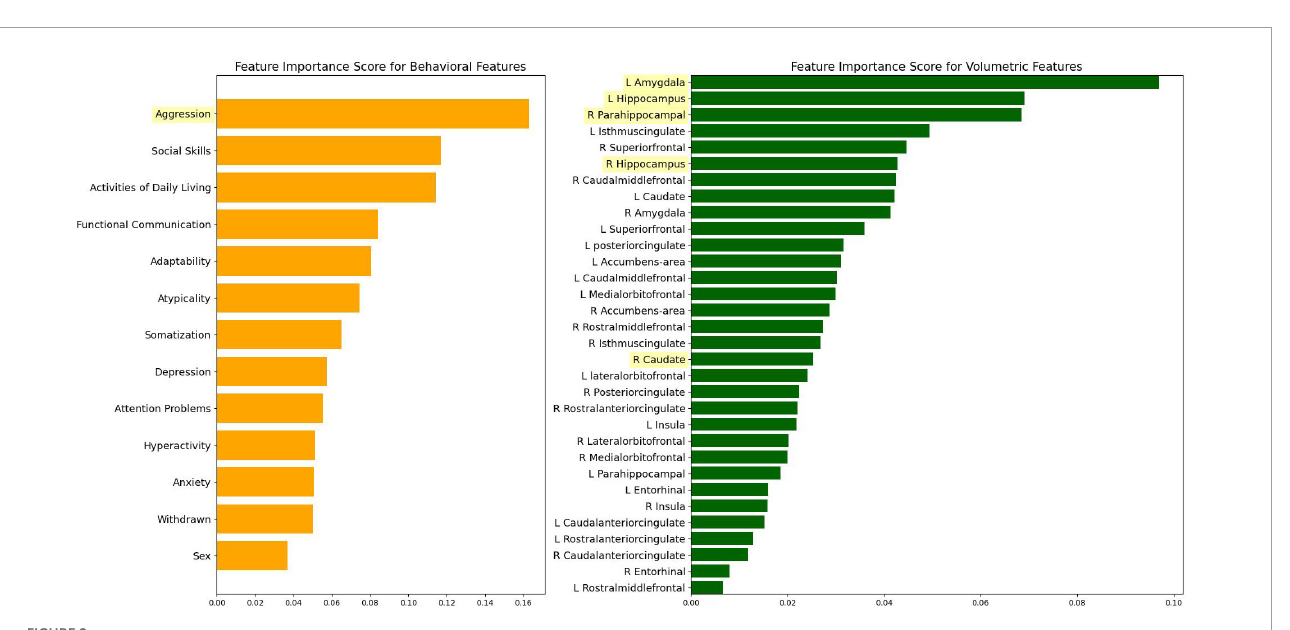
FIGURE2 Ranked feature importance according to different variable